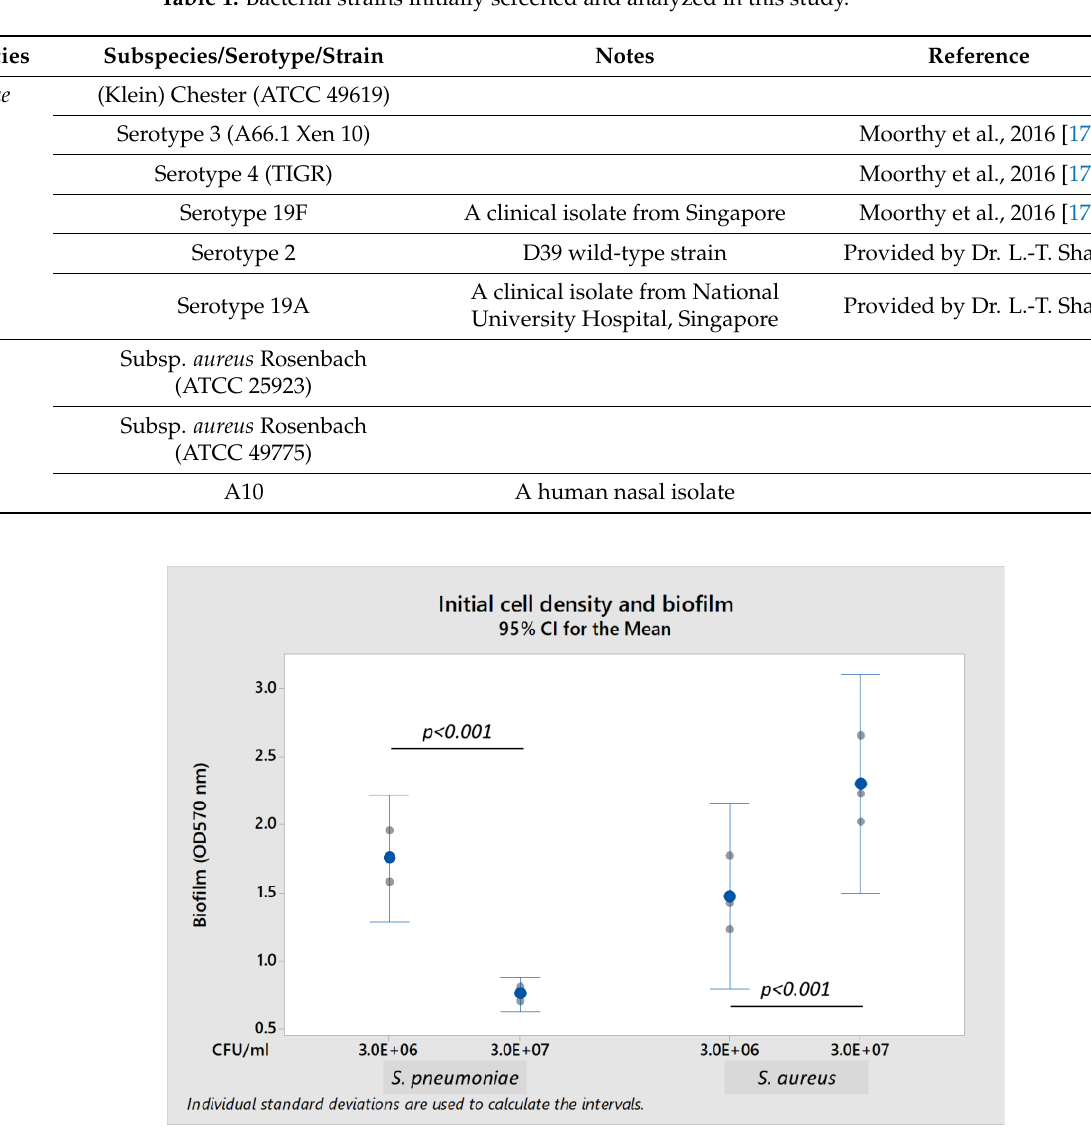
Table 1. Bacterial strains initially screened and analyzed in this study.